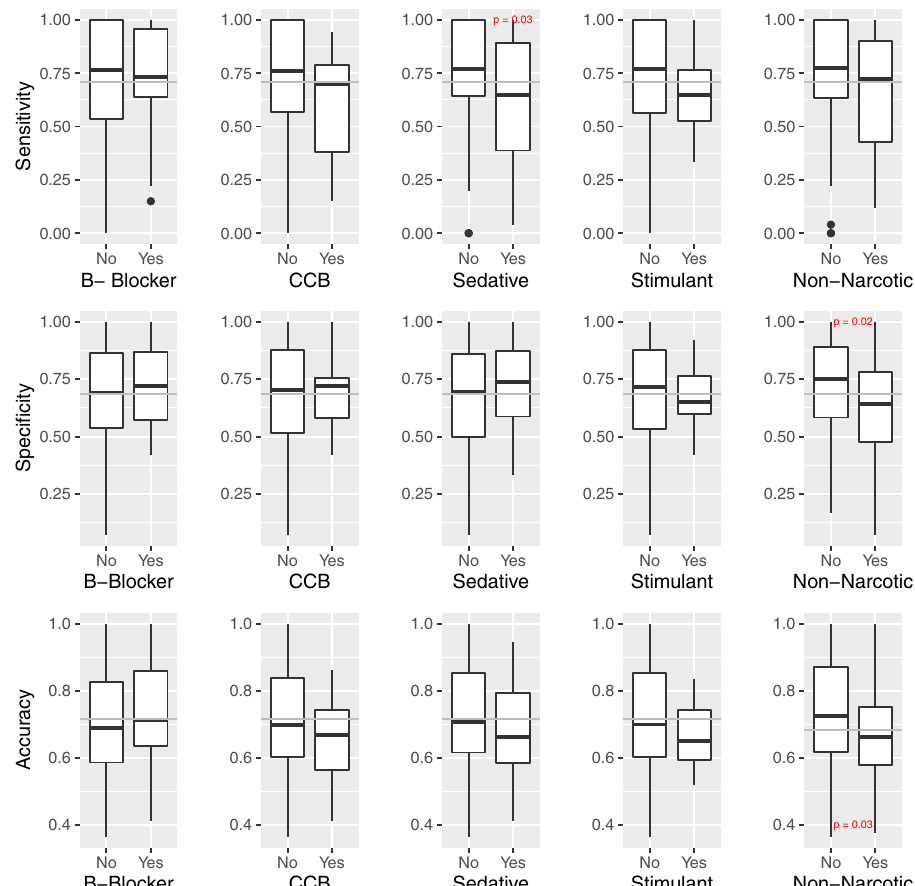
Fig. 7 Model metrics by daily co-administered medication status. Center line = median; upper bound of box = 75th percentile; lower bound of box = 25th percentile; and whiskers = minimum to maximum range, with extreme outliers denoted by black dots. P value based on Wilcoxon rank-sum test. B-blocker beta-adrenergic antagonist, CCB calcium channel milligram equivalents 30 . Pre- and post-opioid administration pain scores were also abstracted from the EMR; however, the documentation of these